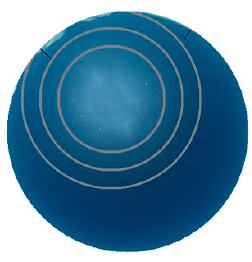
Figure 6. Layering region division.